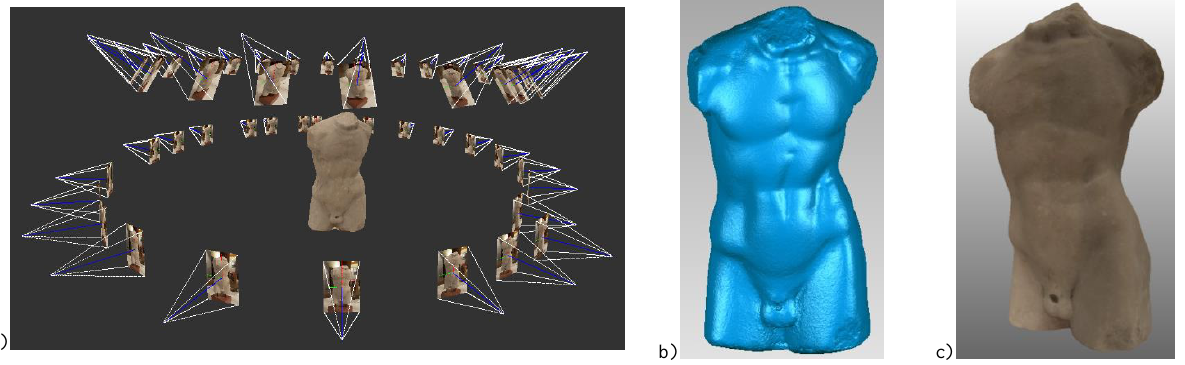
Figure 3: Imaging network for the marble torso (a). Mesh (b) and textured 3D model